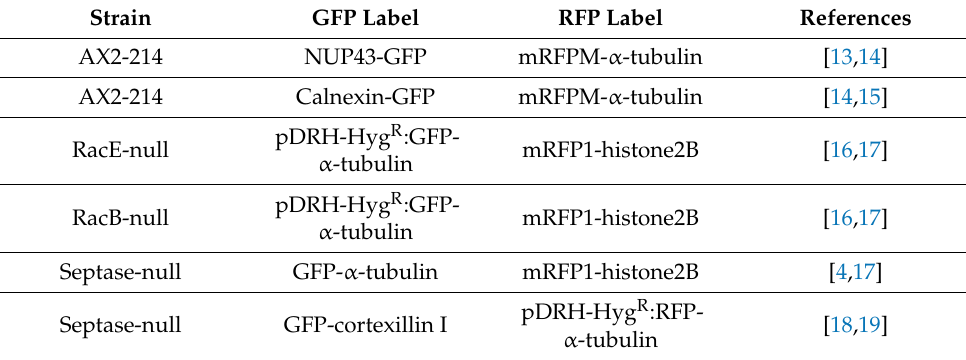
Table 1. List of strains in this paper. Strain GFP Label RFP